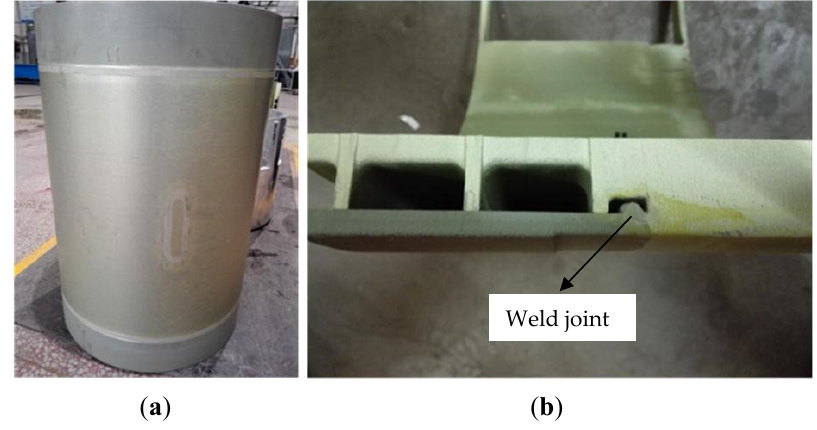
Figure 3. Physic structures of welded sample: ( a ) the 5A06-O/7A05-T6 welded sample; ( b ) the cross section of 5A06-O/7A05-T6 welded joint.